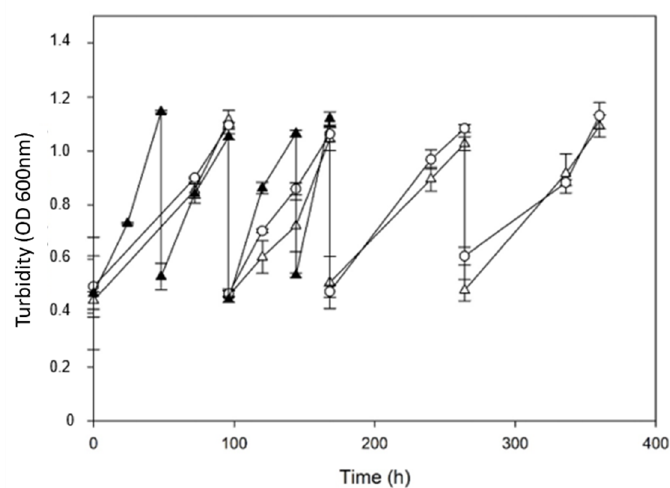
Figure 6. Repeated batch cultures of the bacterial consortium in TW to which PS was added at different concentrations. The bacterial consortium was grown in TW added with the following PS concentrations: (solid triangles) 700 ppm; (open triangles) 1048 ppm; and (open circles) 1398 ppm. The curve for each condition was obtained by calculating the average of three replicates. The details of the cultivation procedure are given in the Materials and Methods section.